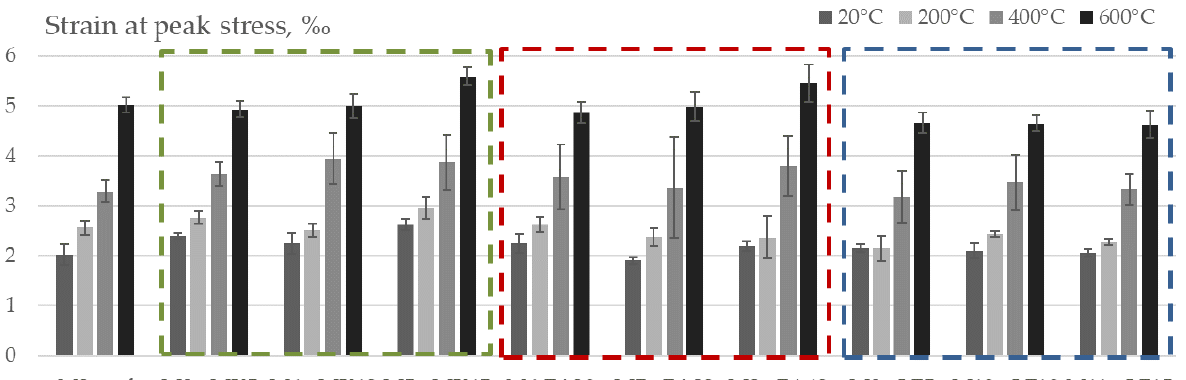
Figure 14. Strain at peak stress vs. temperature of tested mixes.